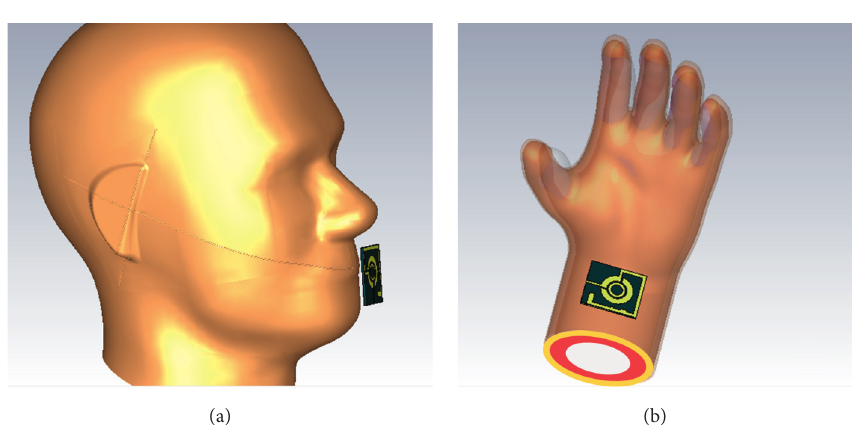
Figure 14: Position of smartwatch antenna: (a) next to SAM mouth model; (b) on the hand wrist model with 4